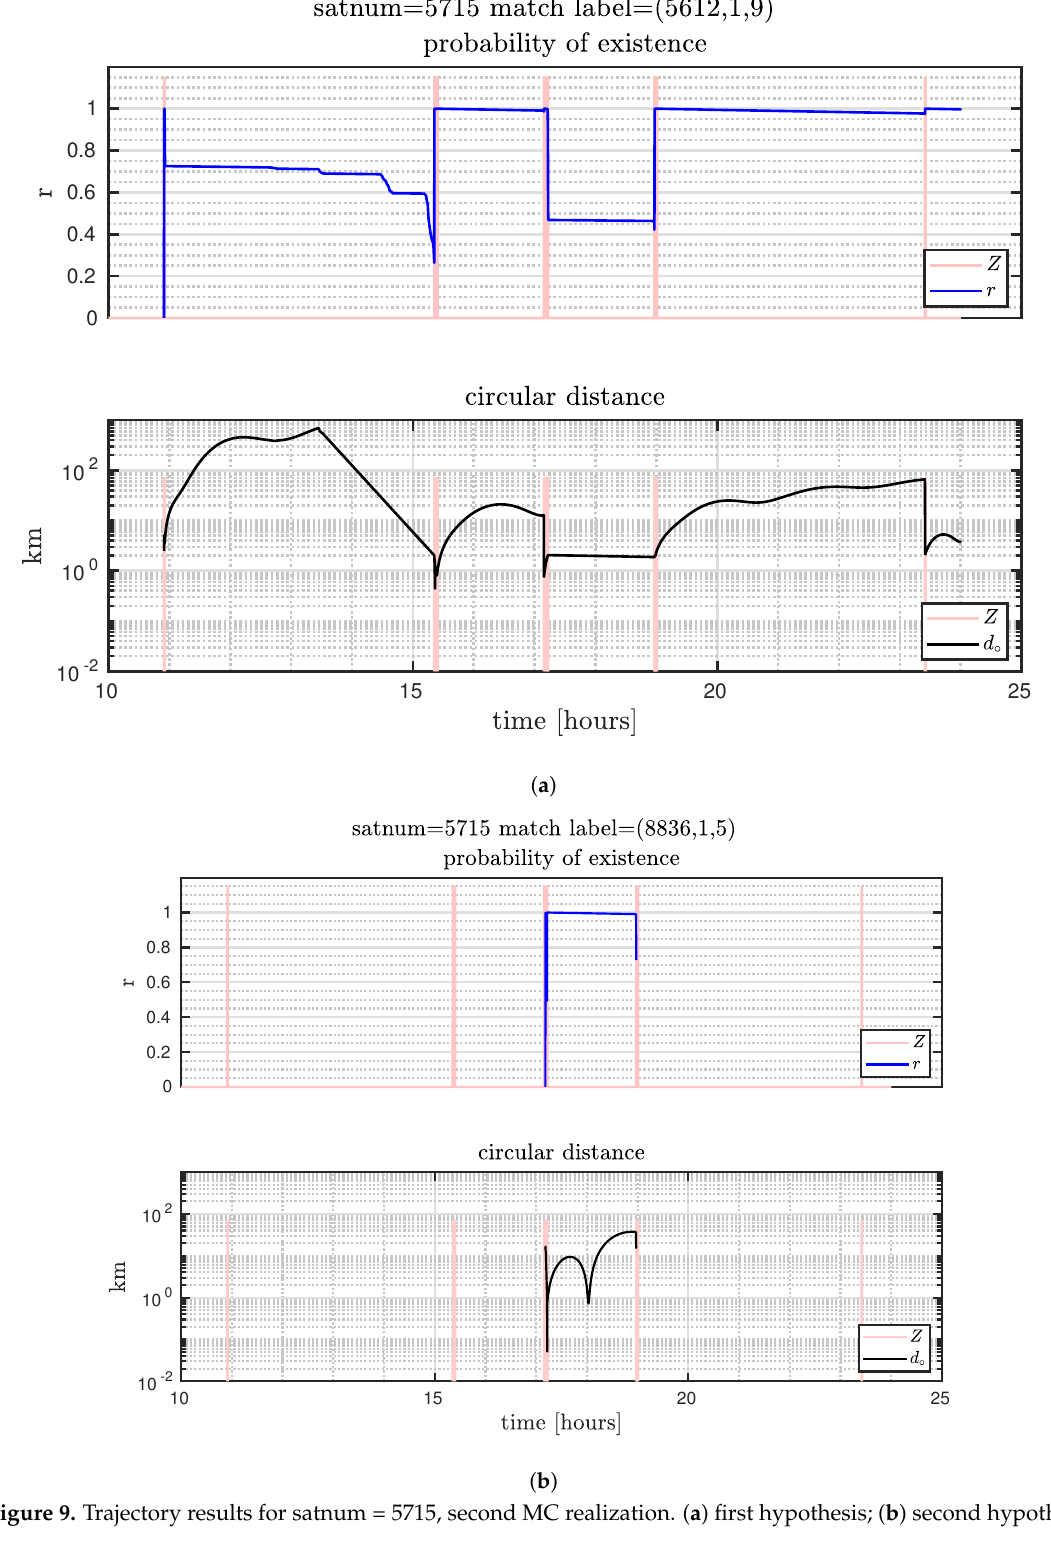
Figure 9. Trajectory results for satnum = 5715, second MC realization. ( a ) first hypothesis; ( b ) second